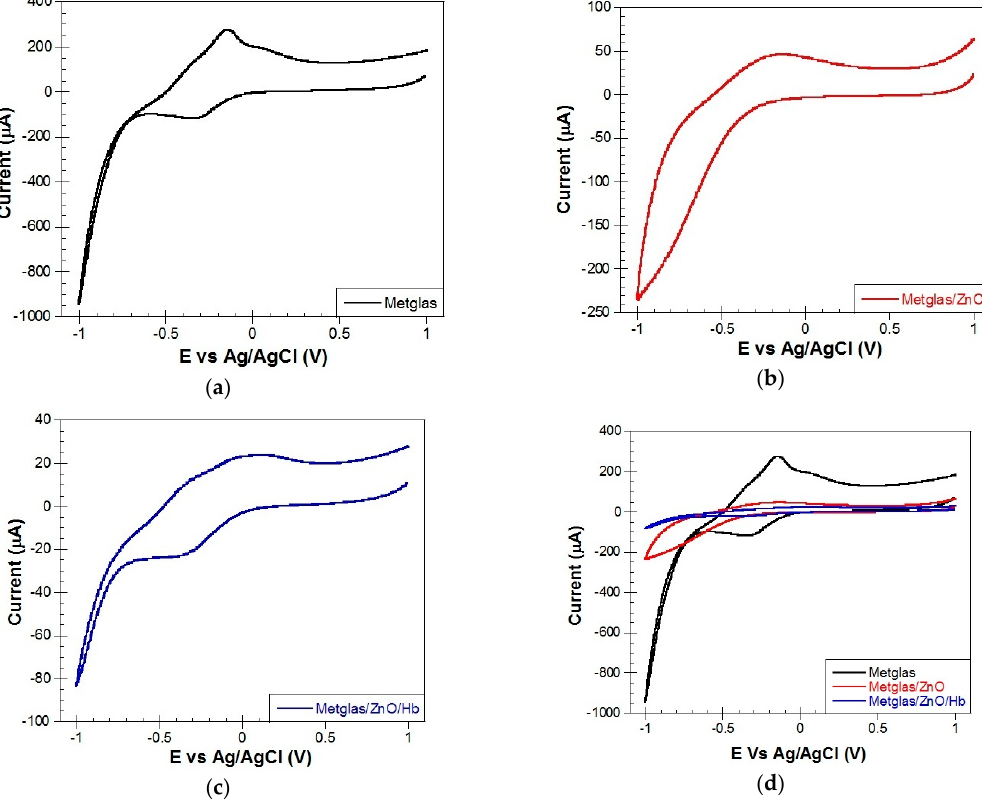
Figure 9. Cyclic voltammetry curves of different electrodes at a scan rate of 0.1 V/s: ( a ) Metglas 2826MB; ( b ) Metglas/ZnO; ( c ) Metglas/ZnO/Hb; and ( d ) all three curves plotted together, for comparison